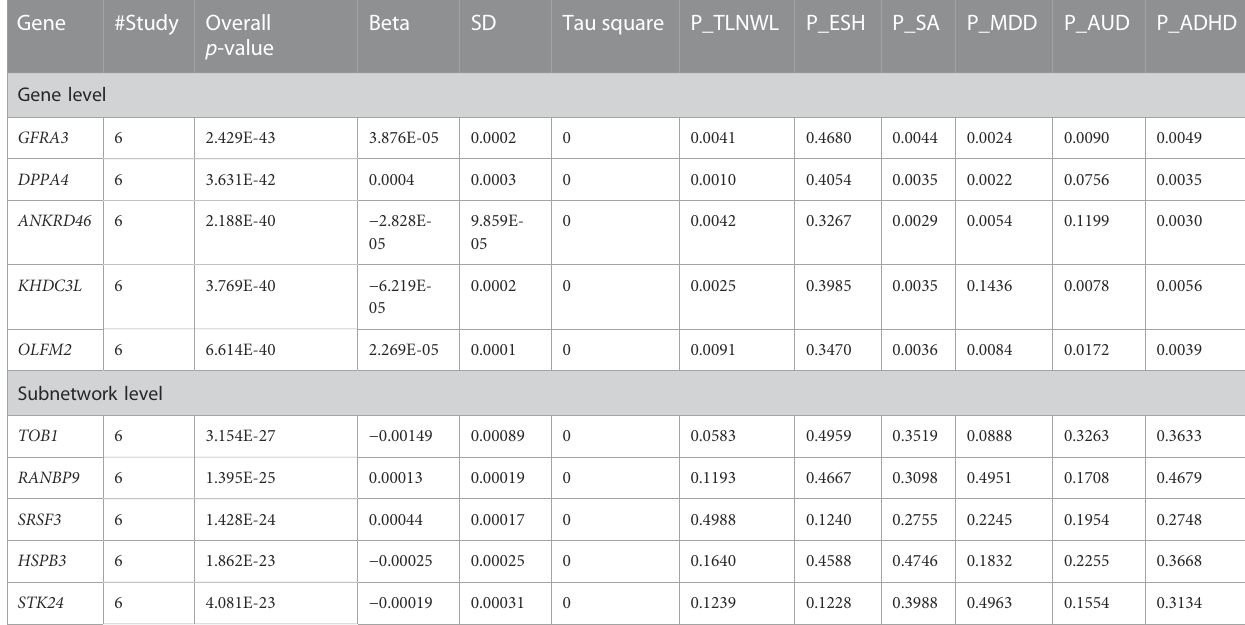
TABLE 4 Top genes identi fi ed by gene and sub-network meta-analysis of the derived common factor. Gene #Study Overall p